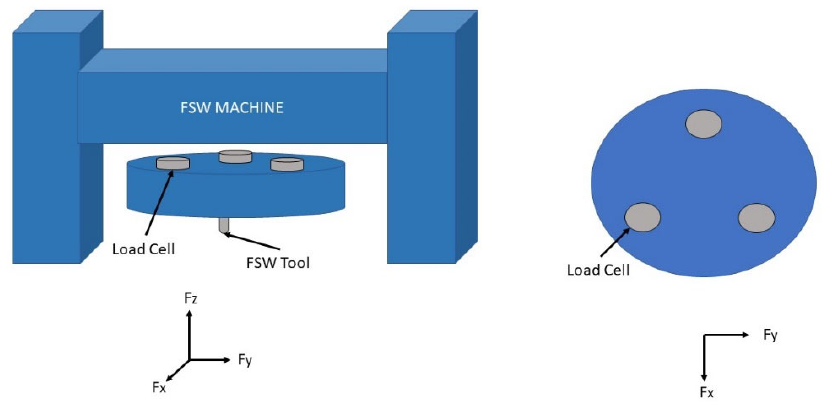
Figure 4. The force measurement system in the RM FSW machine with three triaxial load cells located between the FSW tool and the FSW machine cross beam.